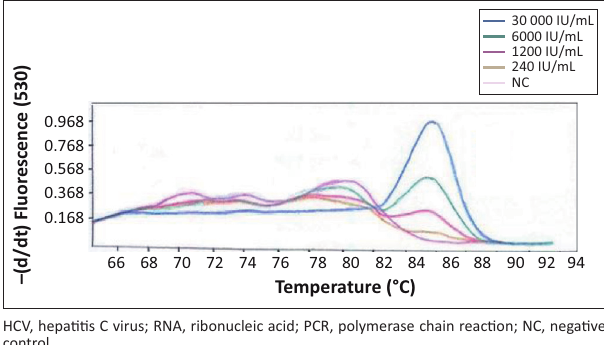
FIGURE 2: External quality controls. The melting curves show results of five-fold dilutions of HCV-positive external quality control specimens. These